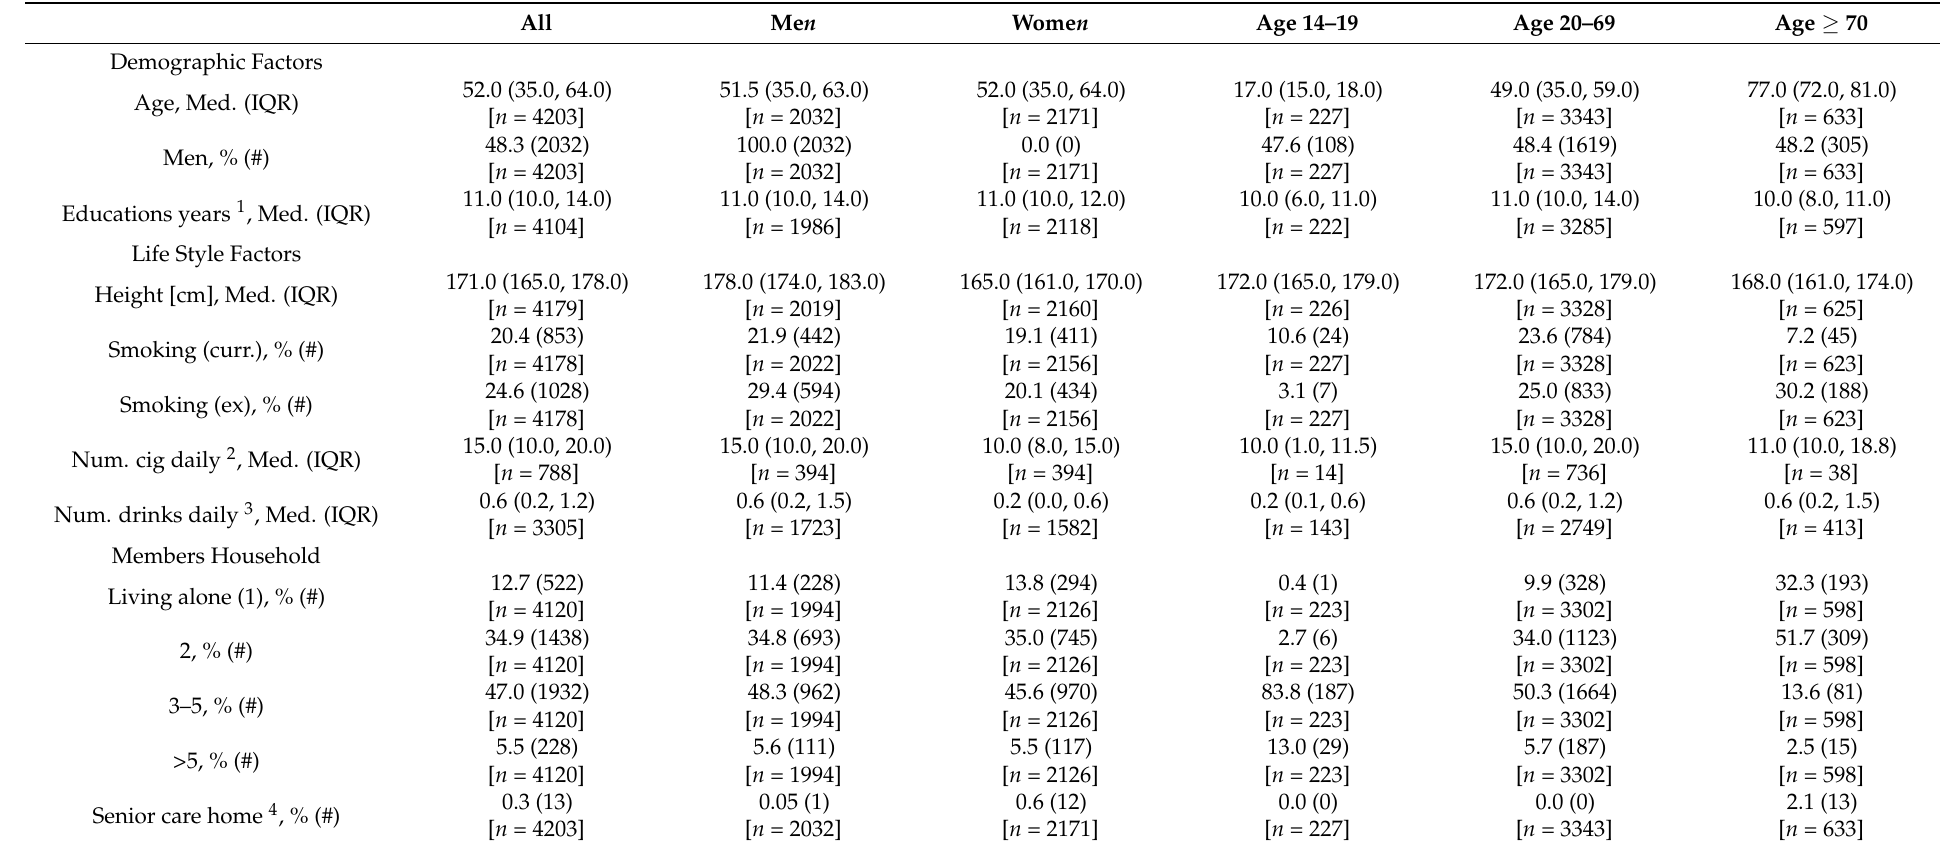
Table 1. Participant characteristics. Shown are characteristics of the 4203 study participants (age, sex) and other characteristics for the 4201 study participants who filled out the questionnaire. Shown are median and (interquartile-range, IQR) or relative (%) and absolute (#) frequencies compared to the non-missing [number of individuals of the